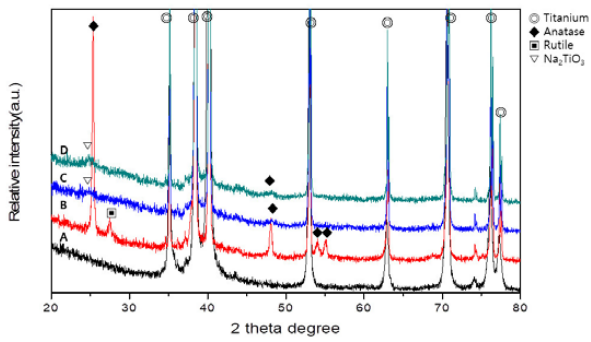
Figure 2. XRD patterns of difference specimens: (A) PT; (B) PTN; (C) PTNA; and (D) PTNAC.